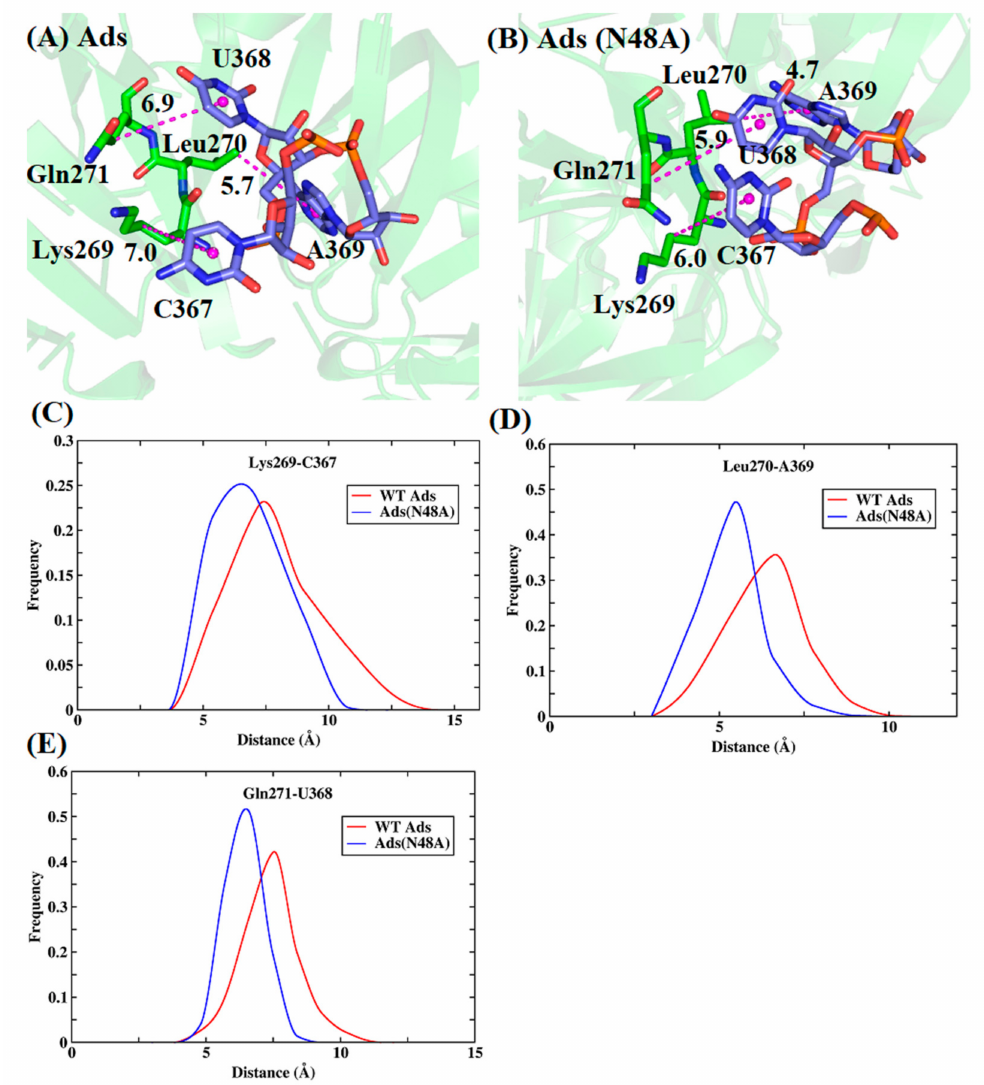
Figure 7. The conformations of the lowest-energy structures and distance distribution of key residues in the Ads and Ads (N48A). ( A ) Ads. ( B ) Ads (N48A). ( C – E ) distance distribution between alkyl of Lys269 and hydrophobic ring of C367 ( C ), alkyl of Leu270 and hydrophobic ring of A369 ( D ), and alkyl of Gln271 and hydrophobic ring of U368 ( E